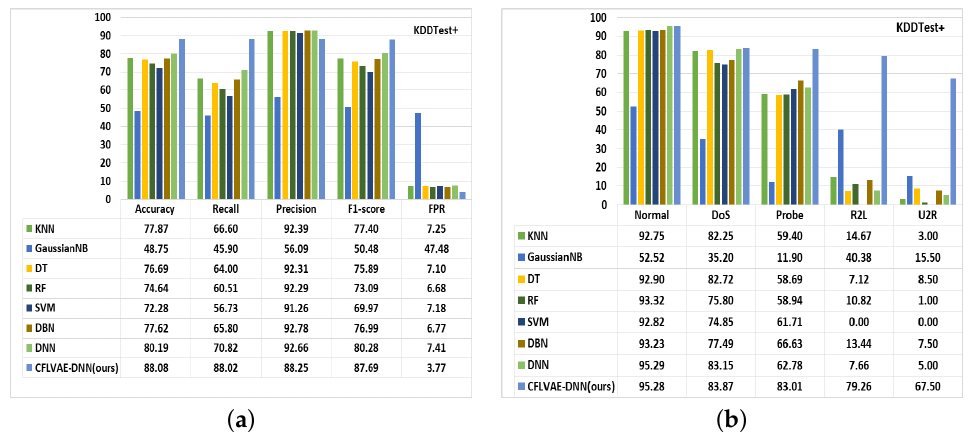
Figure 12. Comparison of ( a ) Overall performance and ( b ) Class-wise detection rates of learning- based classifiers on the NSL-KDD (KDDTest+) dataset (in %).